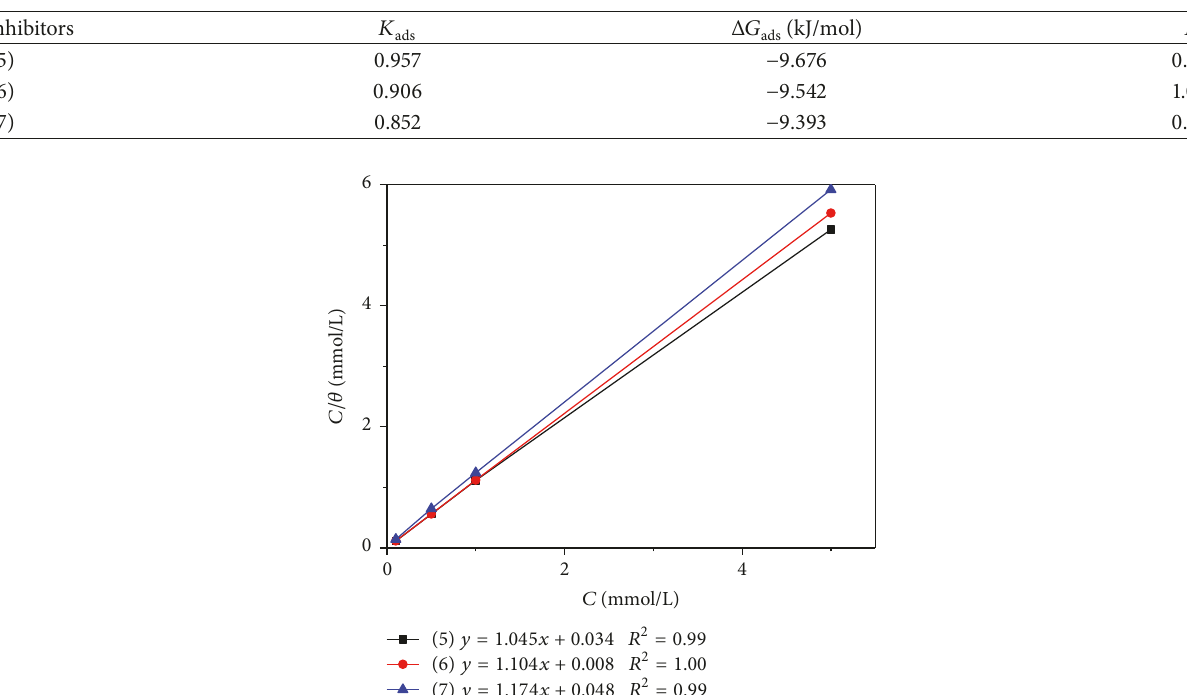
Table 4: Langmuir adsorption parameters and free energy of adsorption of inhibitors on the steel surface at 293 K.